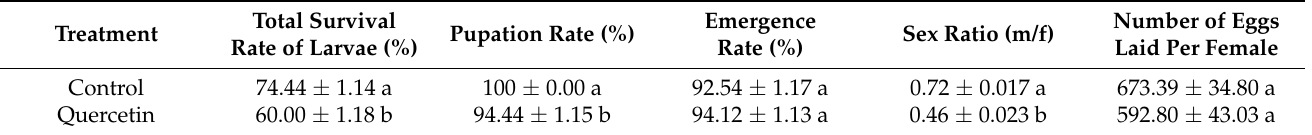
Table 2. The effects of 0.50% quercetin on developmental parameters of third-instar Hyphantria cunea . Treatment